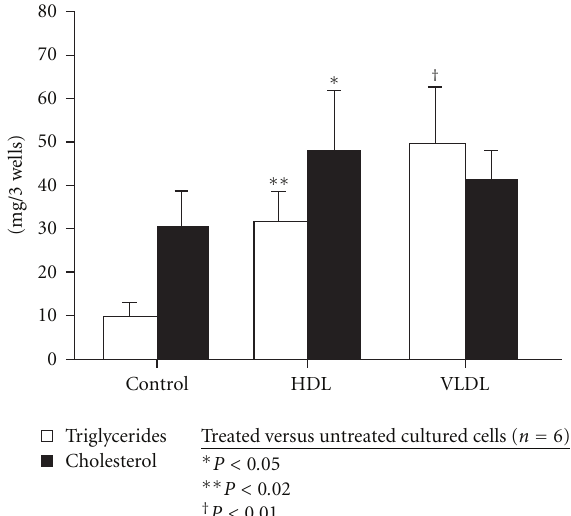
Figure 2: Triglyceride and cholesterol content of cultured sebocytes following treatment with HDL and VLDL. HDL induced signifi- cantly greater concentrations of both triglyceride and cholesterol, whereas VLDL induced a high level of triglyceride accumulation, but had no significant e ff ect on cholesterol accumulation. Triglyc- eride ( n = 5) and cholesterol ( n = 6) were assayed per 3 wells. Means +/ − SEMs are